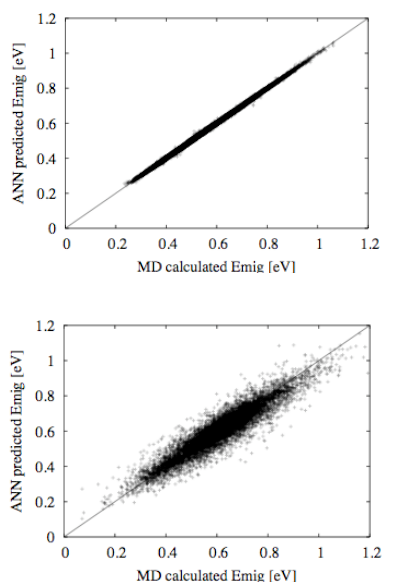
Fig. 10. ANN Prediction qualities for the FeCu3nn (left) and for the FeCuVac3nn (right) (maximum 7 vacancies)